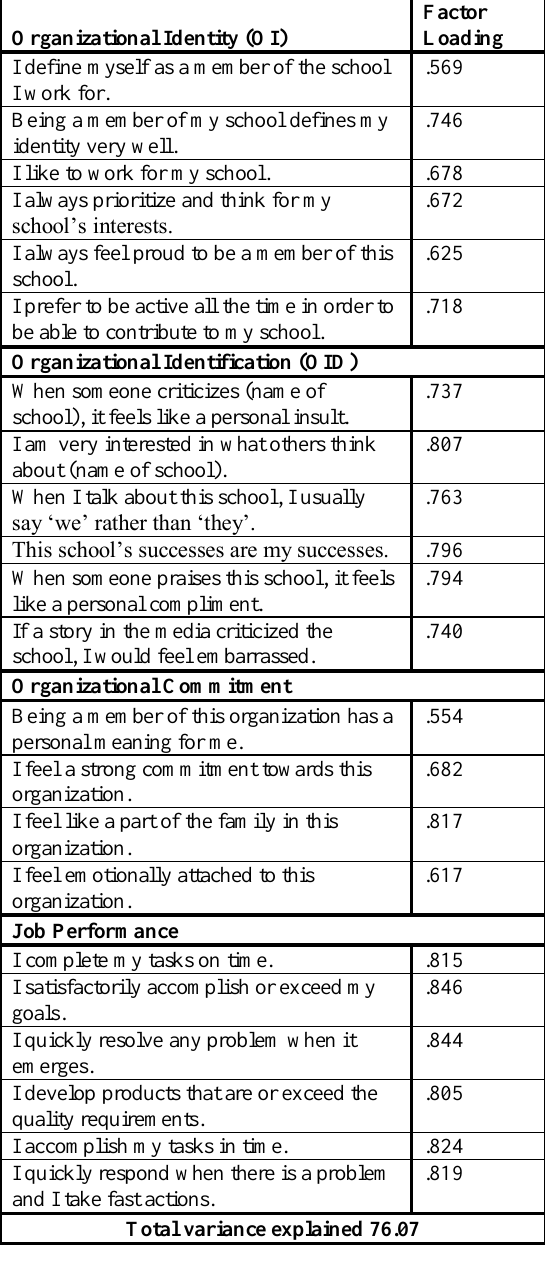
Organizational Identity (OI)